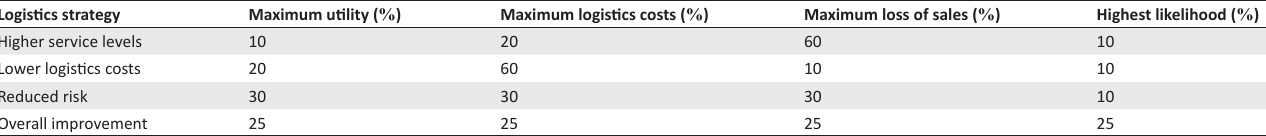
TABLE 7: Variable weightings per strategy.